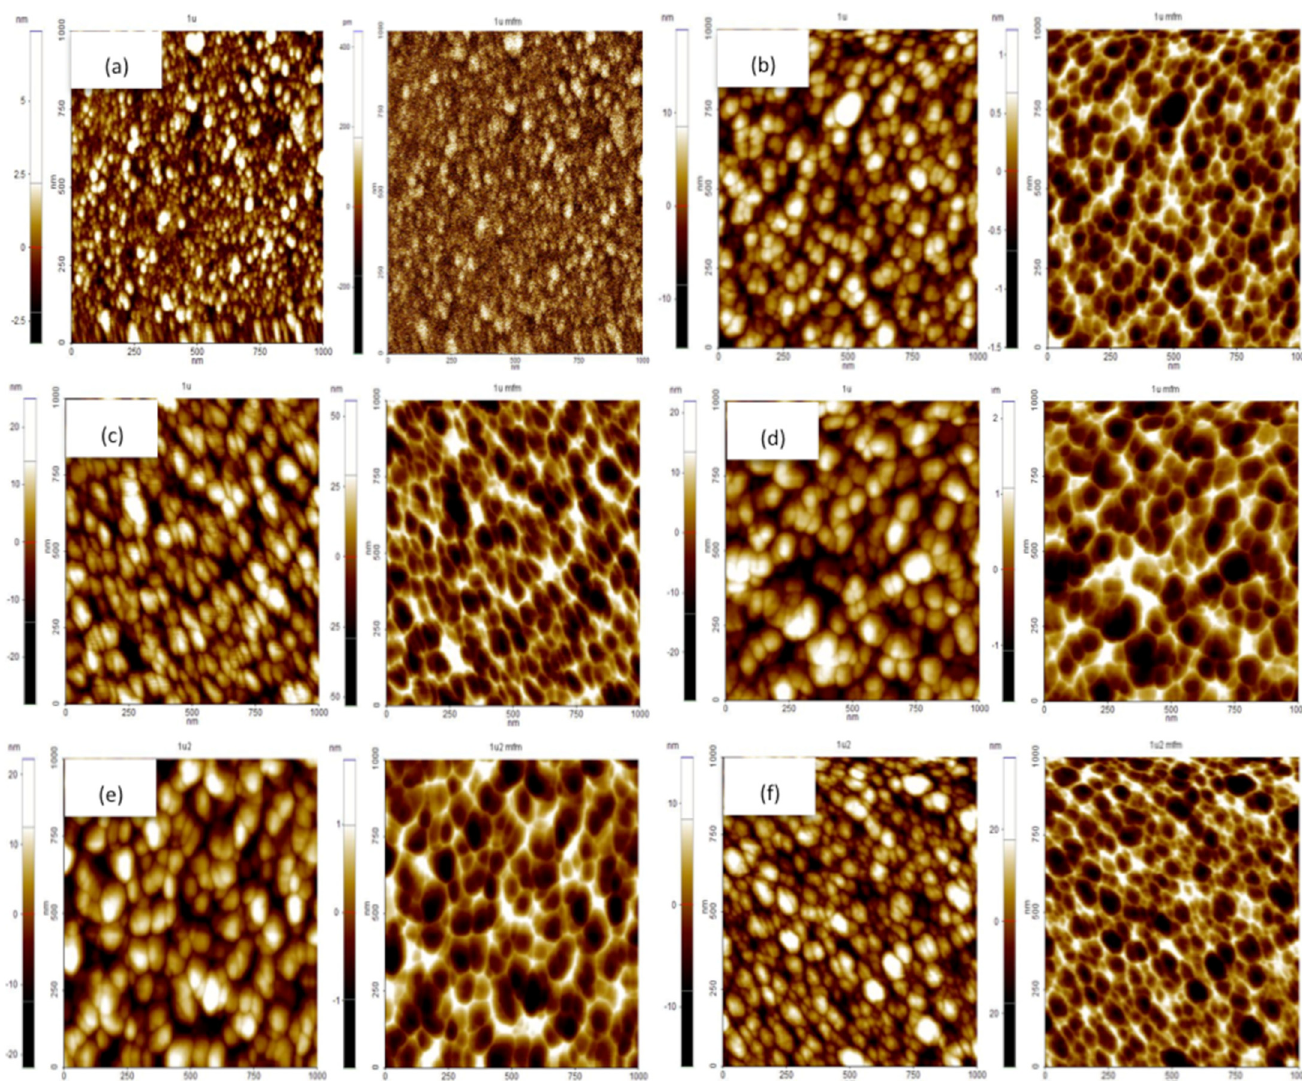
Figure 6. 2D AFM images (left) and 2D MFM images (right) of ( a ) undoped ZnO, ( b ) 1 at%, ( c ) 3 at%, ( d ) 5 at%, ( e ) 7 at% Gd-doped ZnO, and ( f ) 3 at% (Gd, Al) co-doped ZnO films. The cooperation of the spin polarization between the positive south (S) and negative north (N) of the tip and films is equivalent to the attractive forces, whereas the spin polarization between (N) and (N) are respective to the repulsive forces, as shown in Figure 7. Note that these magnetic poles are used to represent the orientation of the tip magnetization. From Figure 6a, there is no bright and dark contrast in MFM images, indicating that undoped ZnO film is non-magnetic. As opposed to Gd-doped ZnO and (Gd, Al) co-doped ZnO films, a magnetic response was observed in the MFM images as a bright and dark contrast, which suggests the existence of ferromagnetism in doped films. This bright and dark contrast in the images describes the domain magnetic structure pattern by the spin polarization of the (S) and (N) magnetic poles, respectively [33]. The presence of the bright and dark contrast expressed from the magnetic forces indicates the intrinsic ferromagnetism and spin polarization in the